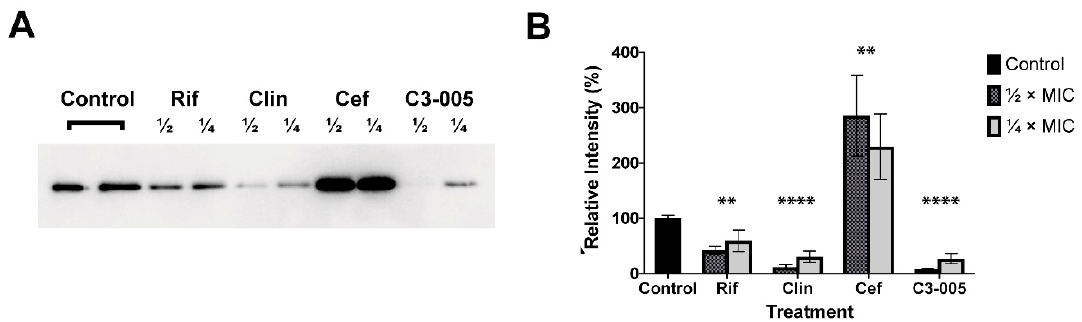
Figure 4. The effect of C3-005 on the secretion of S. pneumoniae pneumolysin. ( A ) Western blot showing pneumolysin levels extracted from culture supernatant following overnight incubation of S. pneumoniae with ½ × (checkered bars) and ¼× (light grey bars) MICs of C3-005 , rifampicin (Rif), clindamycin (Clin), ceftriaxone (Cef), and; ( B ) relative intensity of blotted bands normalized against the drug-free control (solid black bar). One-way ANOVA was used to compare data across the treatment groups. Data was presented in GraphPad Prism style: p ≤ 0.05 (*), ≤ 0.01 (**), ≤ 0.001 (***), ≤ 0.0001 (****).